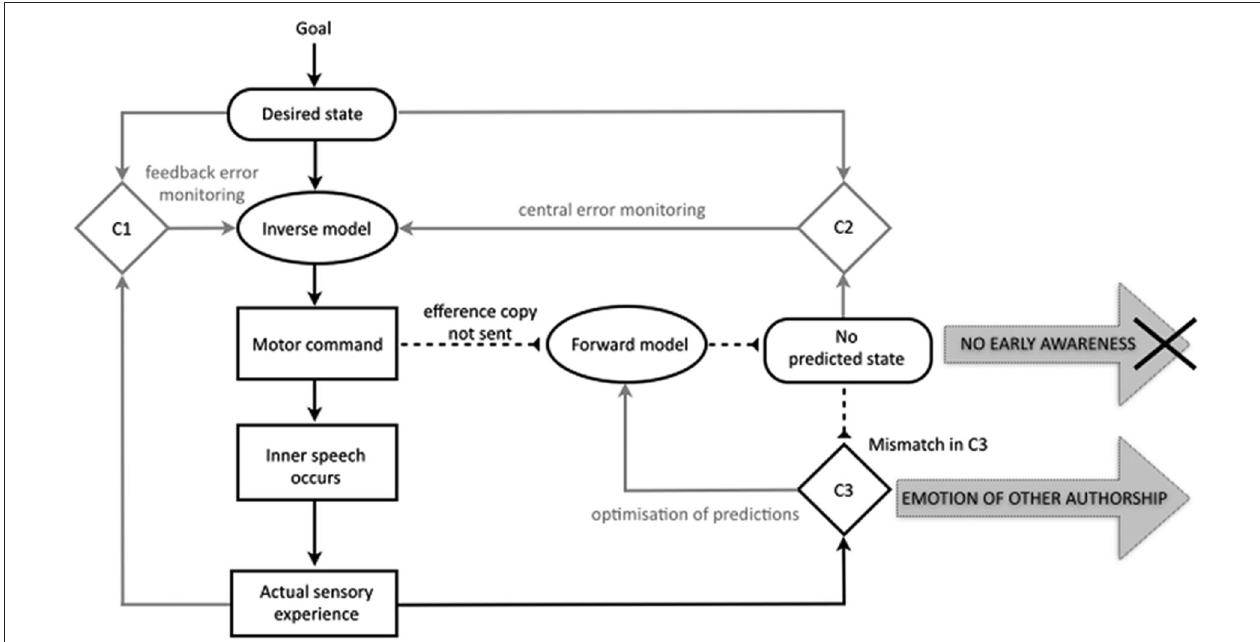
efference copy of the motor command means that no predicted state is generated, leading to a lack of early awareness of the inner speech, and an emotion of other authorship . Based on Jones and Fernyhough (2007), with basic features of the motor control system as in Figure 1 (based on Frith et al., 2000b; Blakemore et al., 2002; Synofzik et al.,